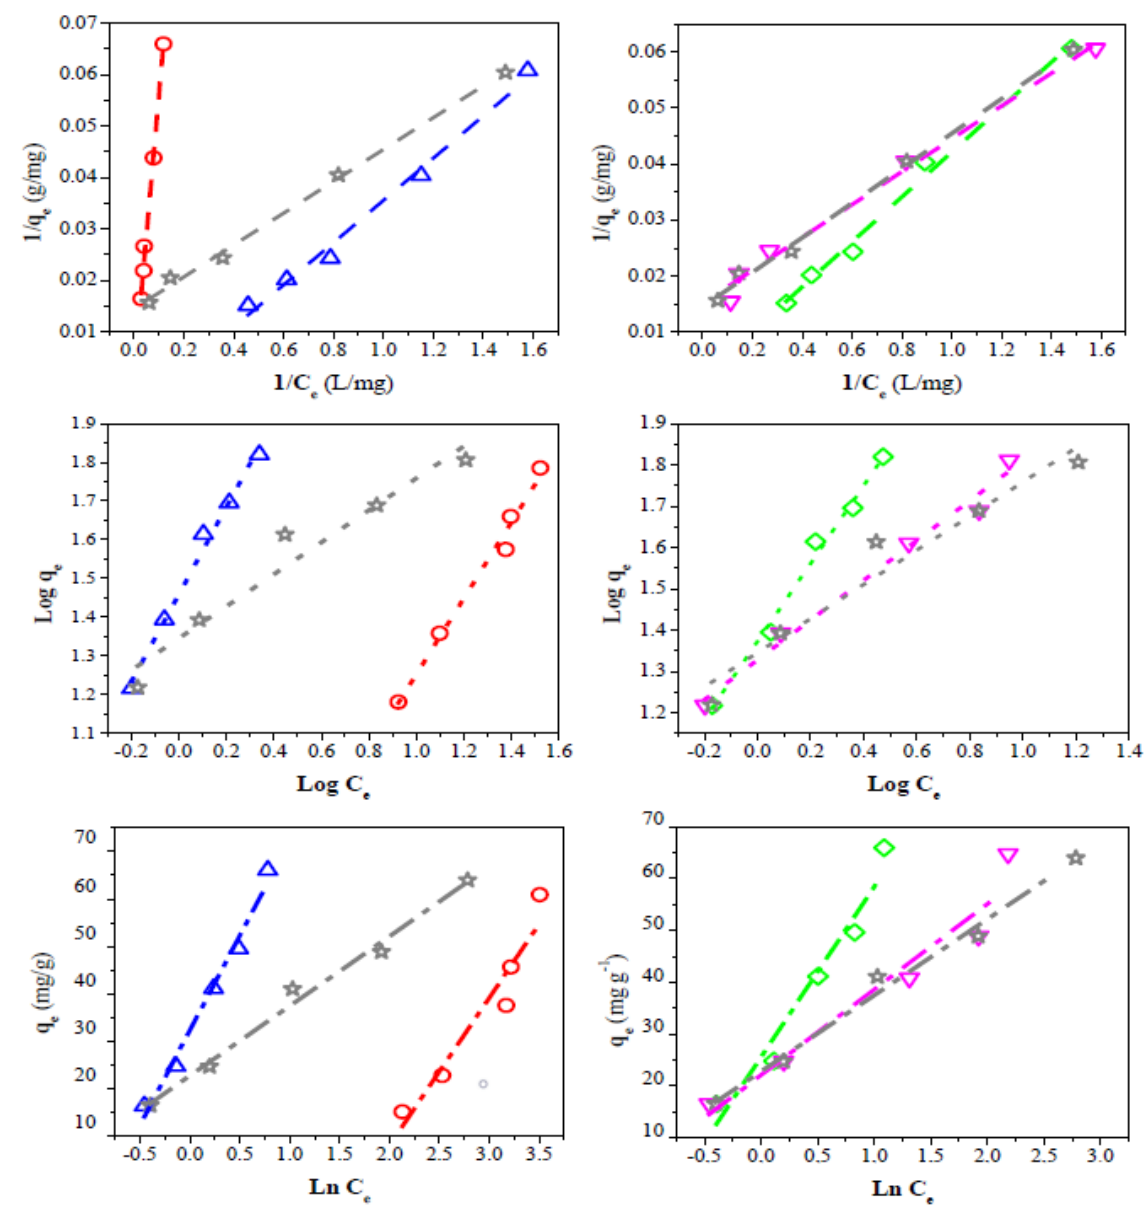
Figure 9. Linear fit of experimental data to different isotherm adsorption models. Langmuir (dash line), Freundlich (dot line), Temkin (dash-dot line). QS-H 2 O ( ◇ ), QS-CO 2 ( ▽ ), CQW-CO 2 ( ☆ ), CQW-P ( △ ), and AC ( ◯ ).